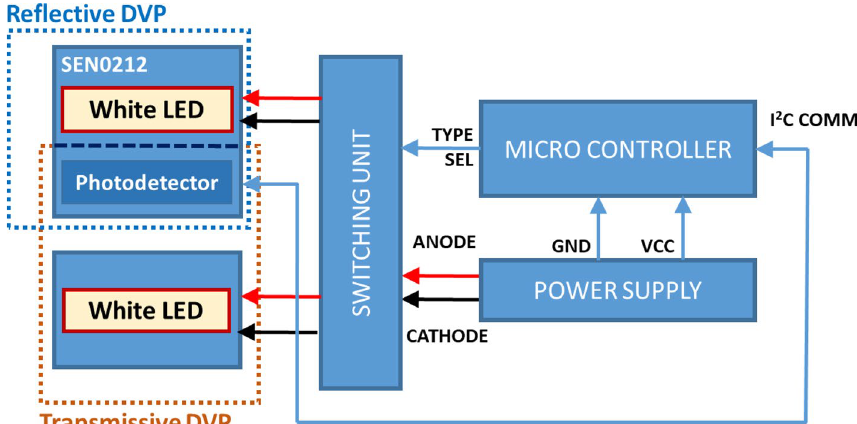
Figure 5. DVP signal acquisition device block diagram.